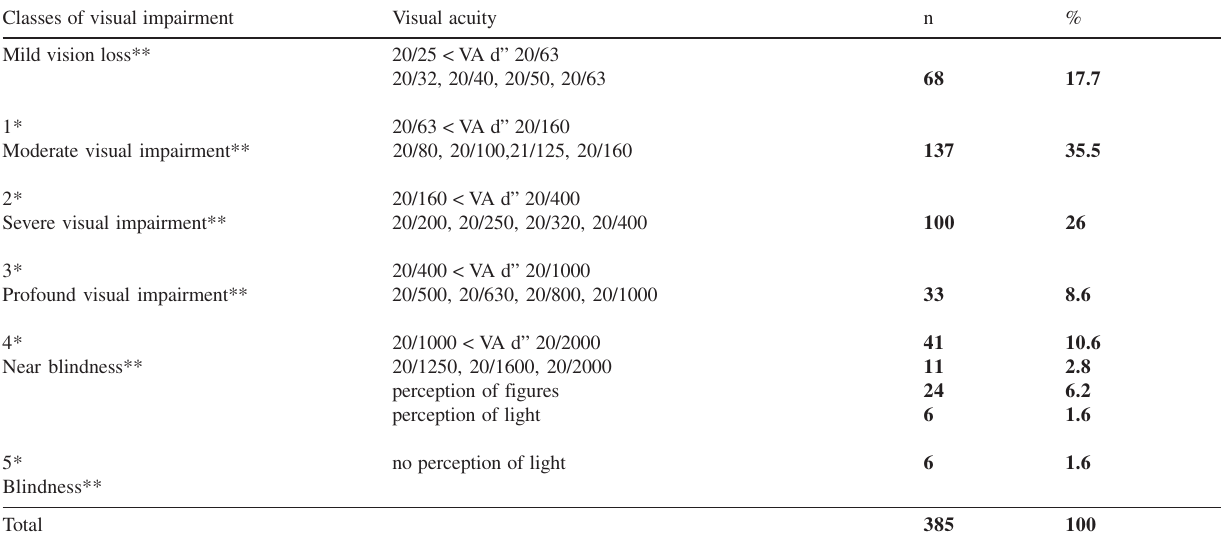
Table 1 - Distribution of the pediatric population by visual acuity and classes of visual impairment Classes of visual impairment